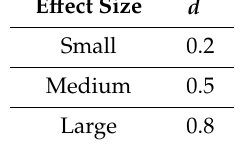
Table 8. General rule for a rough quantification of the effect size [20].